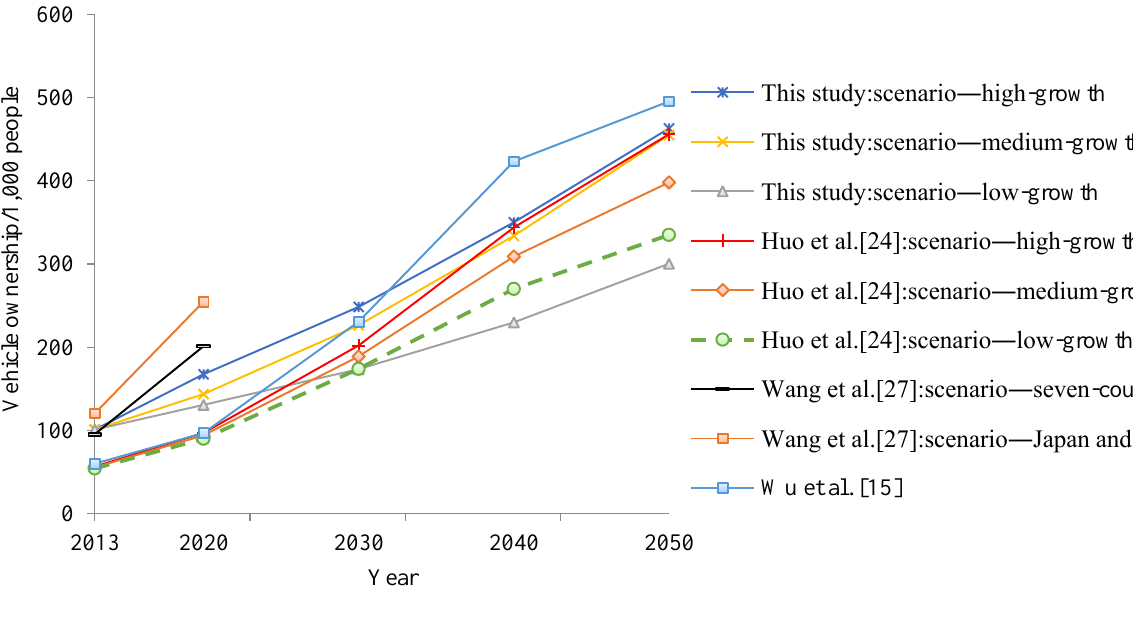
Figure 9. Vehicle stock projections across various studies.